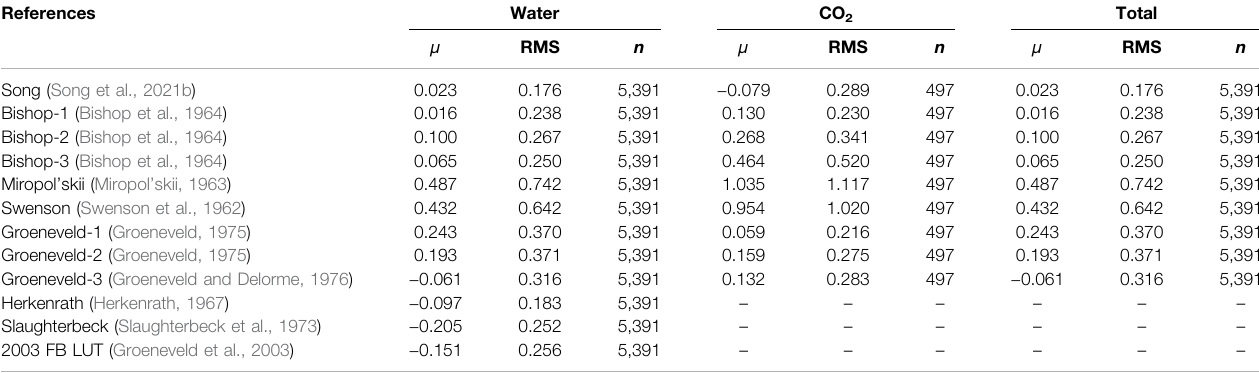
TABLE 8 | Predictive capability of post-CHF prediction